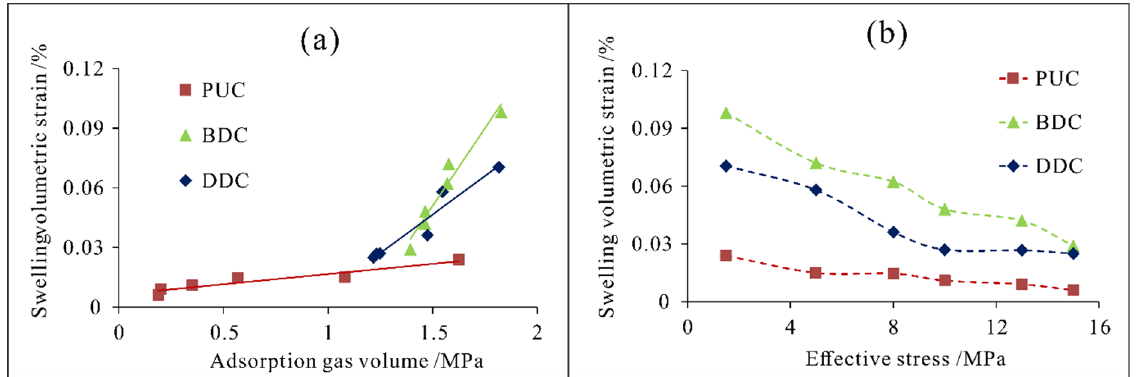
Figure 7. Changes in absorption swelling of coal cores with adsorption gas volumes ( a ) and effective stresses ( b ).